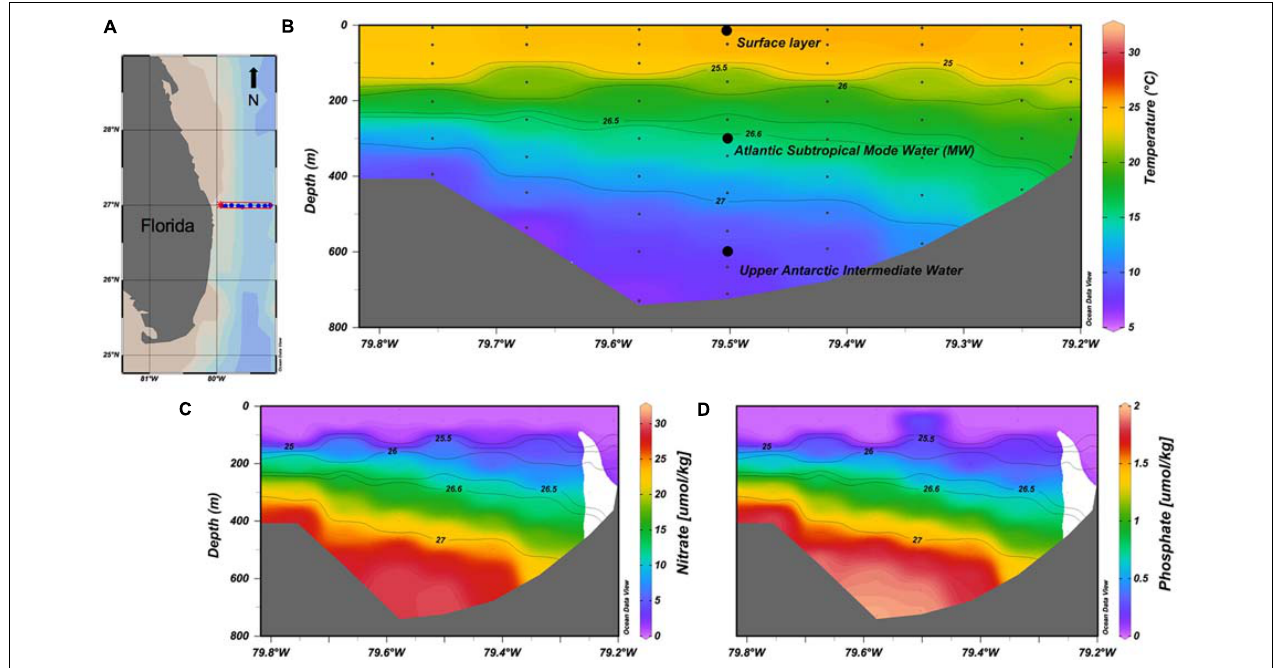
FIGURE 2 | In color, temperature (B) , nitrate concentrations (C) , and phosphate concentrations (D) in the Florida Strait (A) at the time of the cruise. All section plots are overlain with distributions of potential density ( σ θ ). The sampling location and depths are shown in relation to water masses sampled (B) . Plotted using Ocean Data View software (Schlitzer,